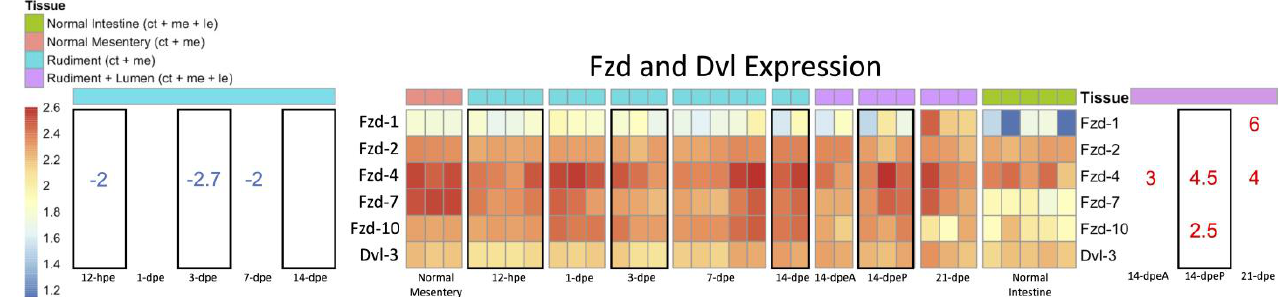
Figure 6. Heatmap of Fzd and Dvl expression during early- and late-stage regeneration. This figure can be read the same as the heatmap from Figure 5. The significance threshold is the same.